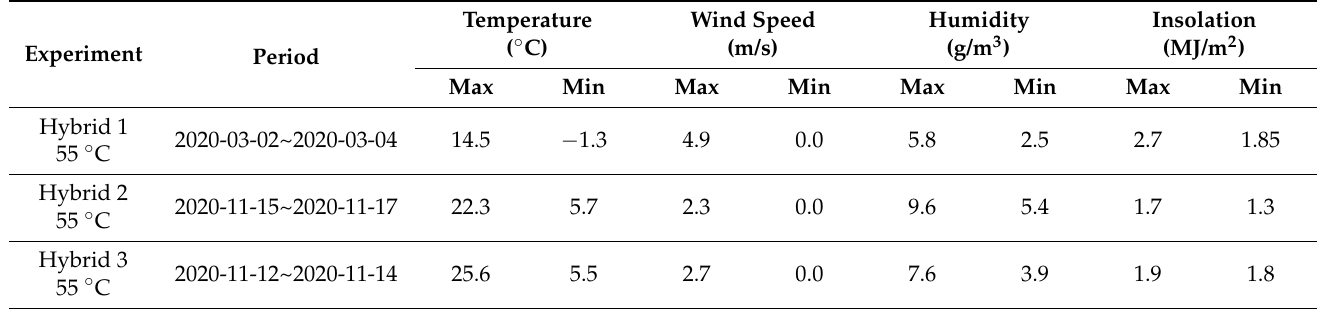
Table 3. Weather data during experimental